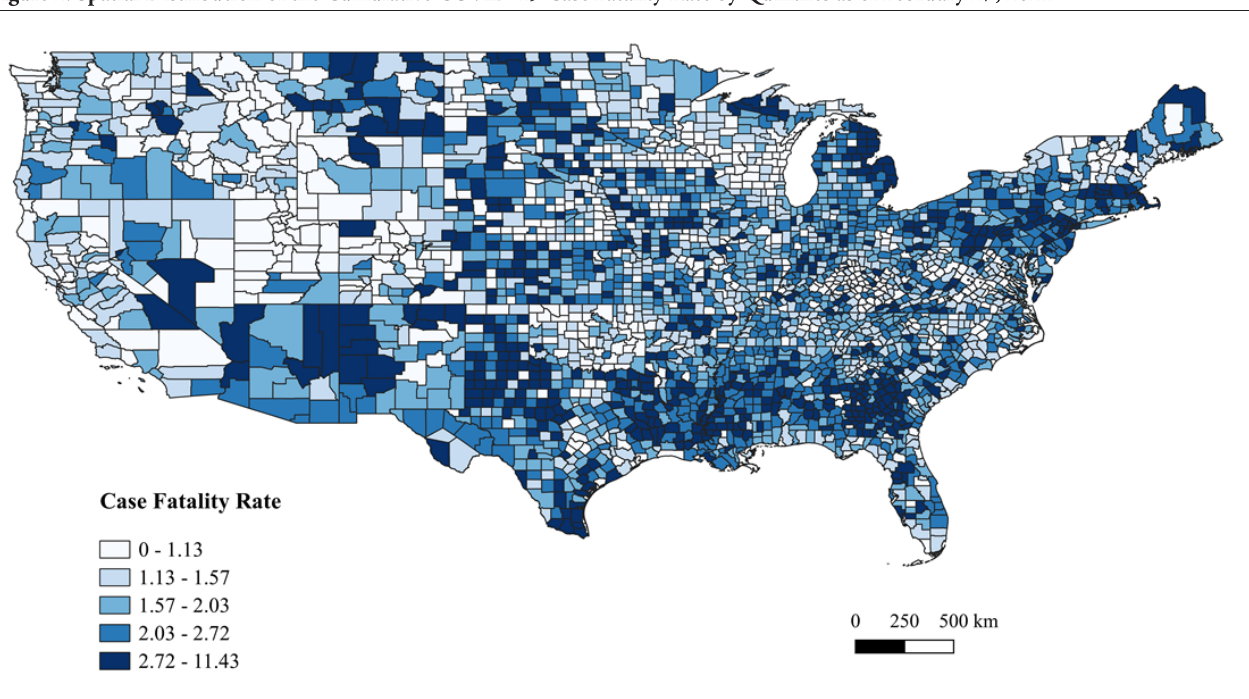
Figure 2: Spatial Distribution of the Cumulative COVID-19 Case Fatality Rate by Quintiles as of February 27,